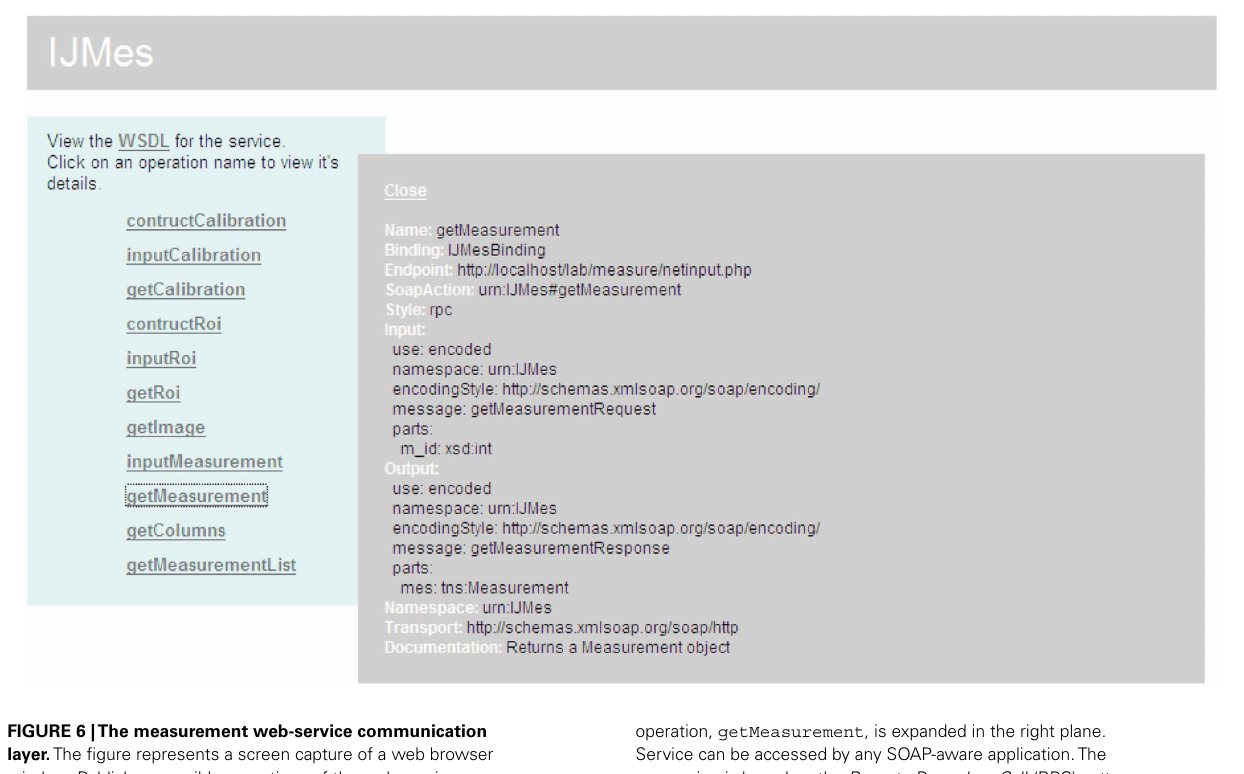
operation, getMeasurement , is expanded in the right plane. Service can be accessed by any SOAP-aware application.The messaging is based on the Remote Procedure Call (RPC) pattern of the SOAP